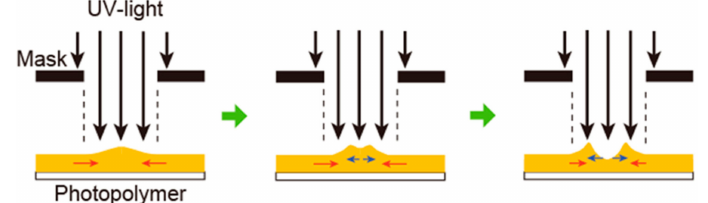
Figure 4. Surface volume changes in the photopolymer material film.